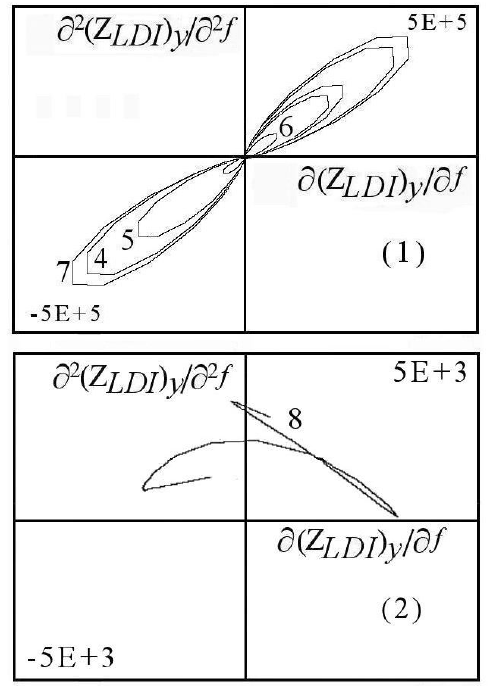
Figure 27. Phase-space at equilibrium potential at low frequency in Figure 24. ( 1 ): hydrogen adsorption, events 4 to 7; ( 2 ): partial projection, and changing perspective view for unstable event 8 in Figure